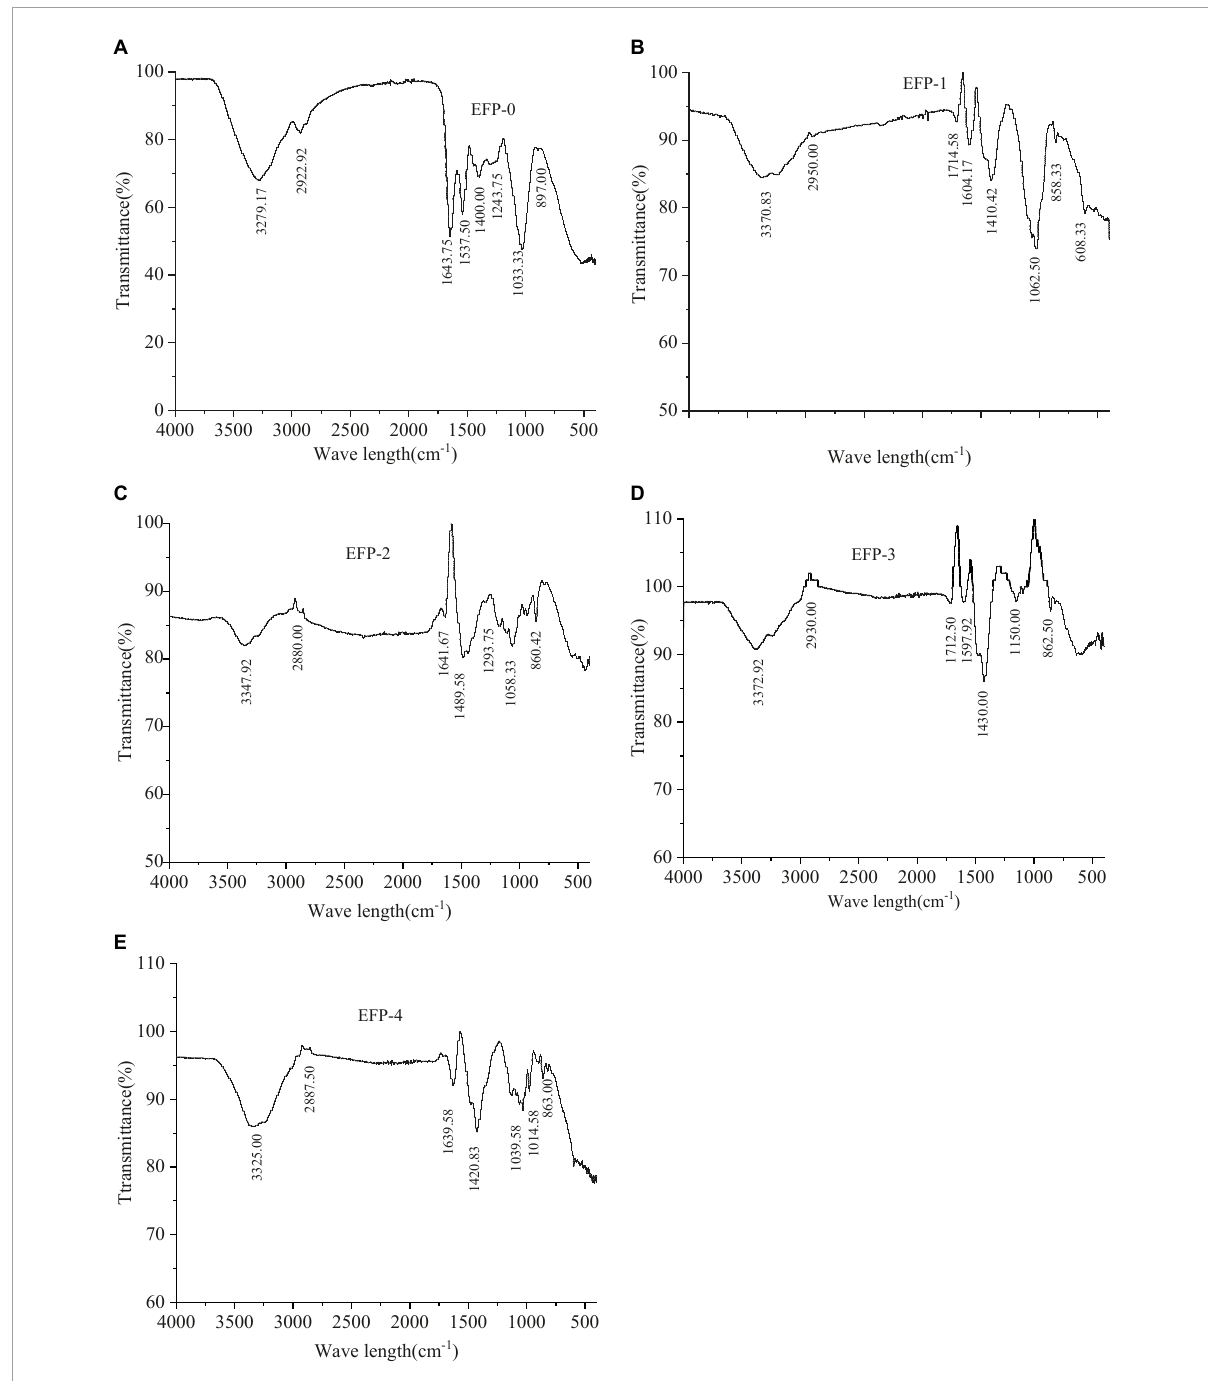
FIGURE3 Infrared spectra of the five polysaccharide fractions of elderberry fruits and (A–E) represents the infrared spectra of EFP-0, EFP-1, EFP-2, EFP-3, and EFP-4, respectively.